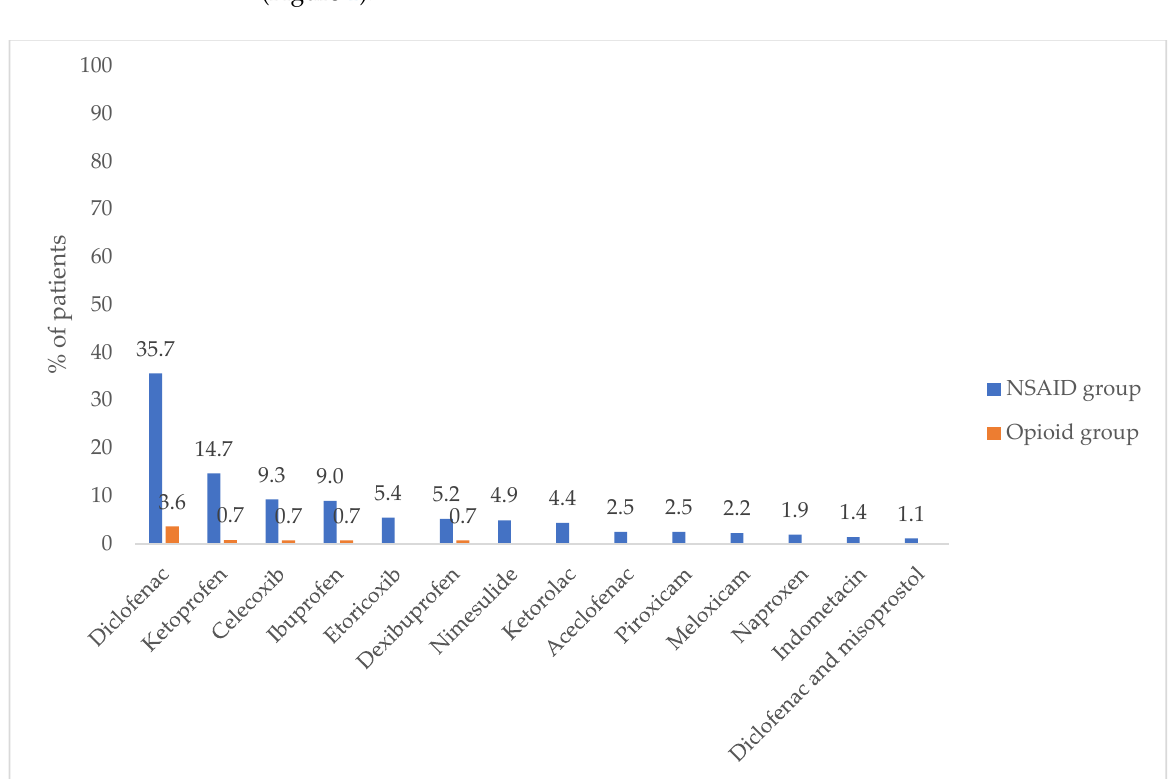
Figure 1. Percentage of patients with NSAID prescriptions. Abbreviations: NSAIDs, Non-Steroidal Anti-Inflammatory Drugs.